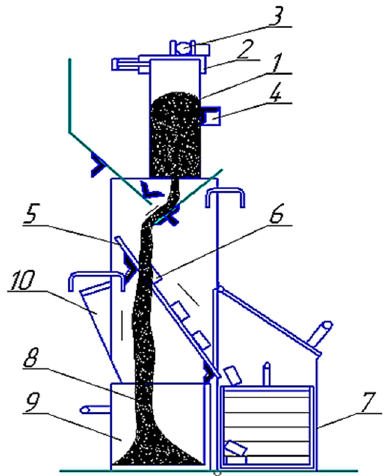
Figure 2. The design scheme of the separator: 1—container; 2—socket; 3—shaft; 4—limiter; 5—inclined lattice; 6—parts; 7—hardening tank; 8—carburizer; 9—metal container; 10—lid.